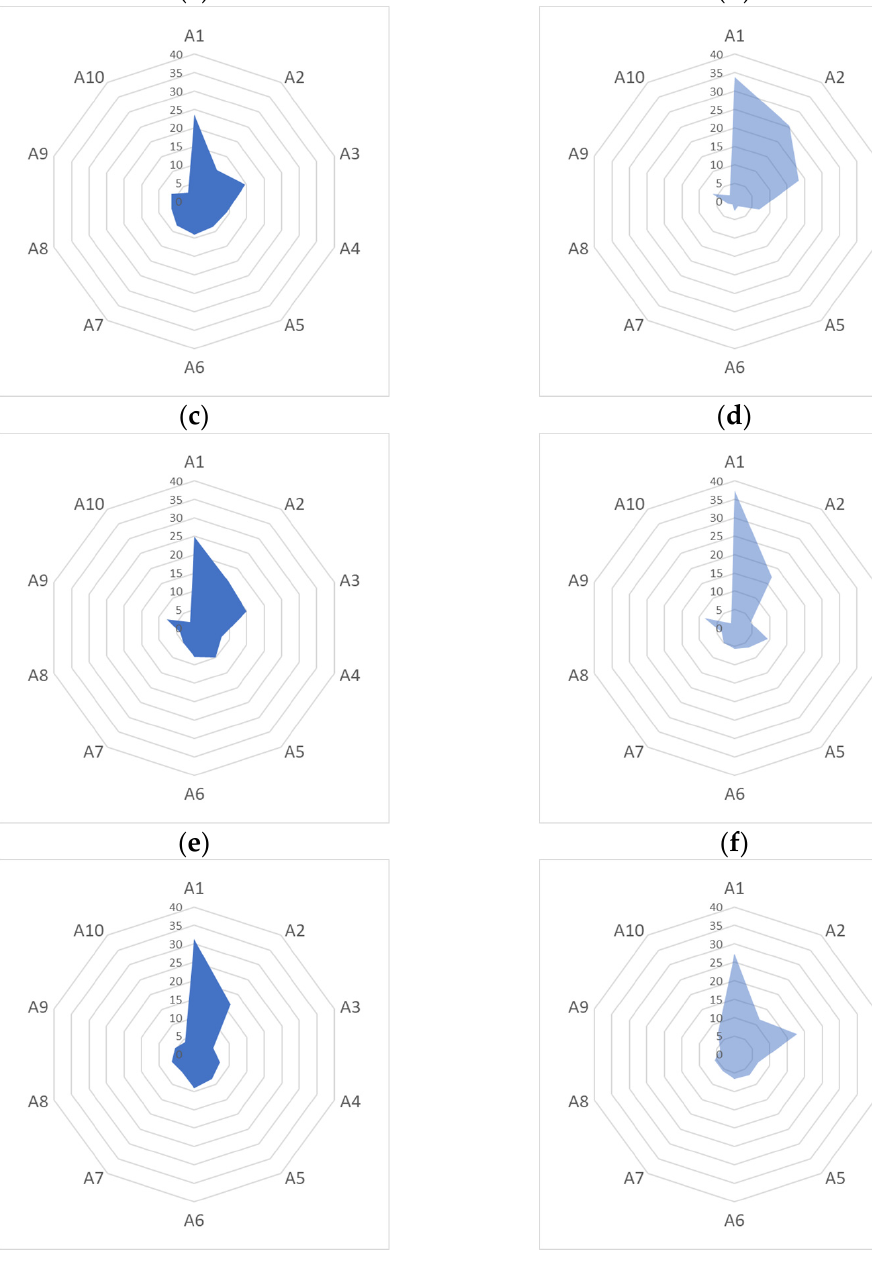
Figure 4. Country profiles for biomass feedstock preferences based on the attributes considered and the size of the facility (combustion). The estimated weights for the attributes are expressed as percentages. (Canada n = 4, n = 1, Finland n = 1, n = 3, Sweden n = 2, n = 5, values for ≤ 5 MW and >5 MW, respectively). For definitions of the attributes, see Table 1. ( a ) Canada ( ≤ 5 MW), ( b ) Canada (>5 MW), ( c ) Finland ( ≤ 5 MW), ( d ) Finland (>5 MW), ( e ) Sweden ( ≤ 5 MW), ( f ) Sweden (>5 MW).